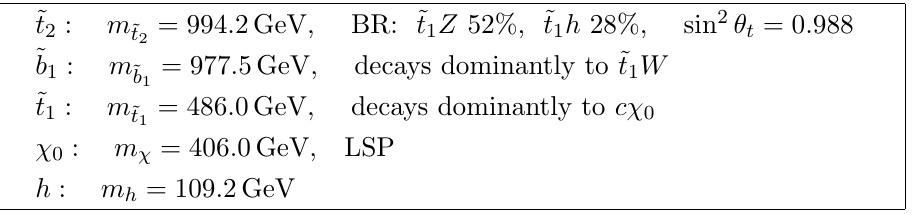
Table 5 . Mass spectrum and branching ratios for MSSM benchmark point. Note that while the stop and sbottom mass parameters are consistent with all current experimental constraints, the correct Higgs mass is not produced in this MSSM scenario, signaling the need for additional physics beyond the